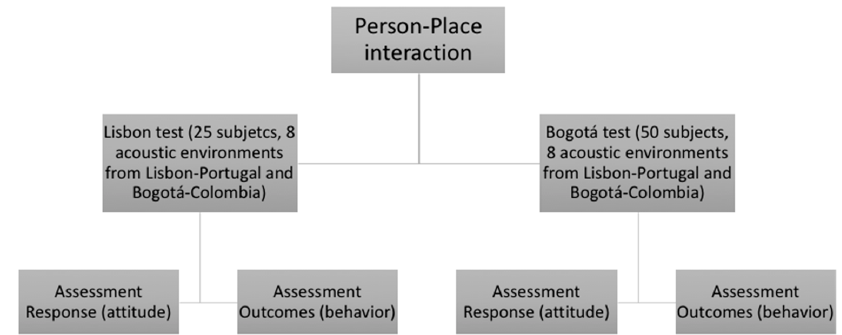
Figure 2. General design of the subjective evaluation test.